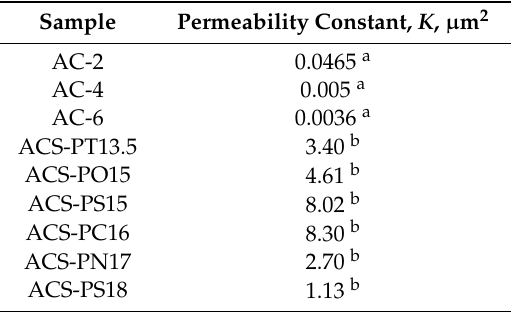
Table 3. Permeability data of the di ff erent samples. Average for three initial pressure di ff erences (300,500,700 mbar) with their standard deviation.